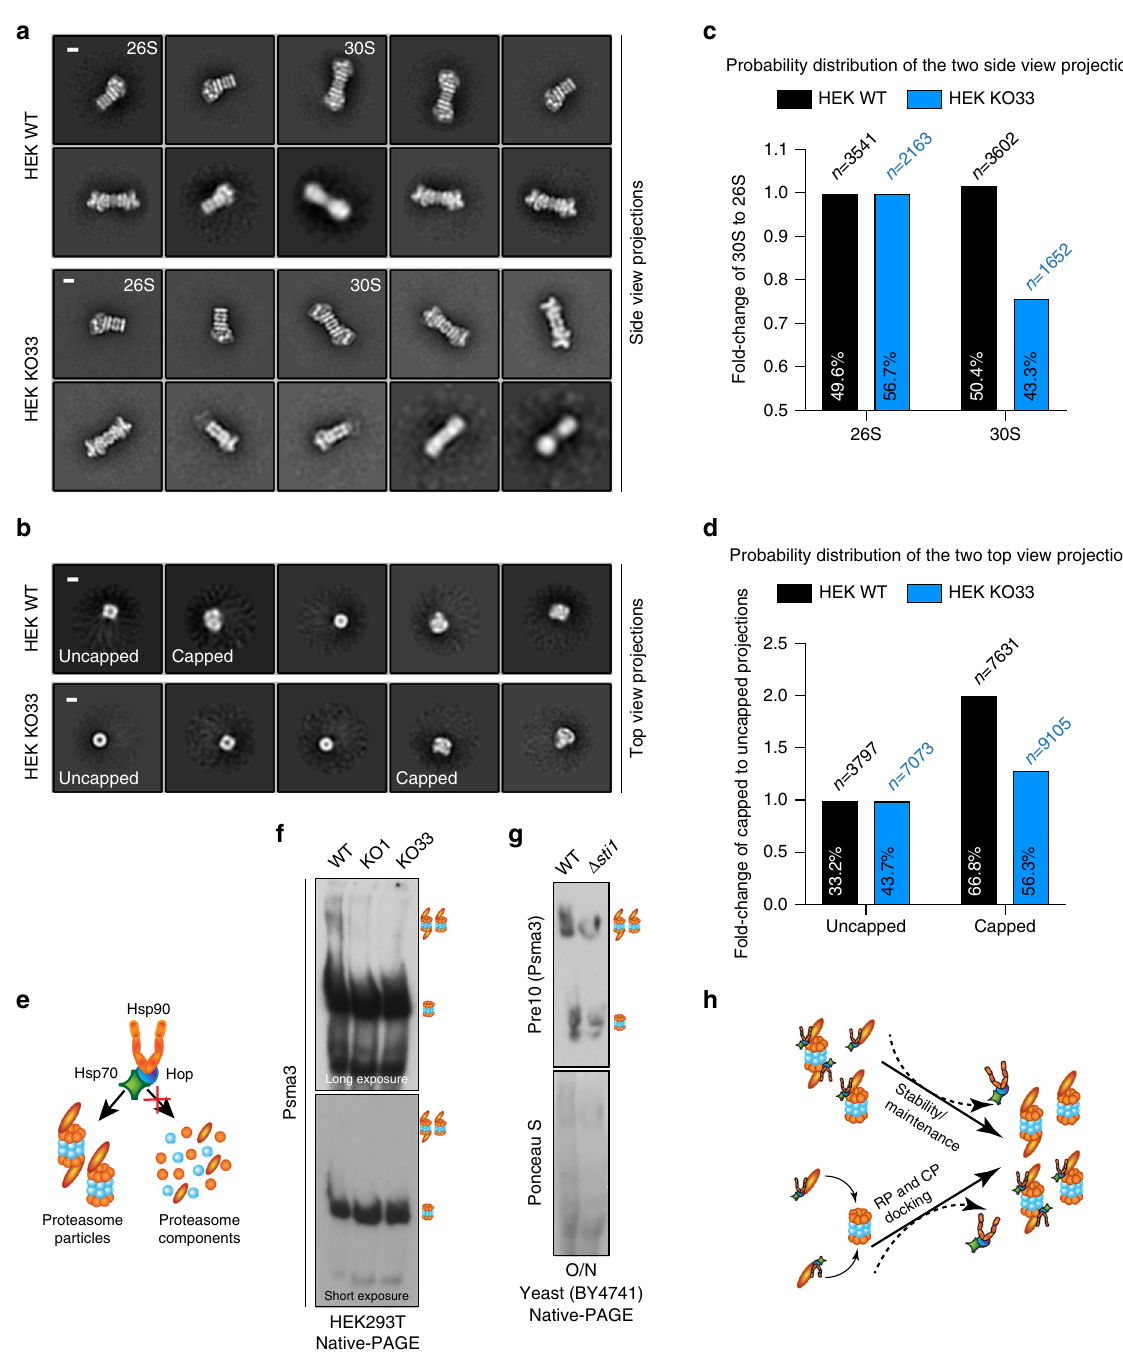
Fig. 5 Hsp70-Hop-Hsp90 ternary complex is required for proteasome assembly. a , b 2D class-averaged images of puri fi ed proteasome particles obtained by negative staining TEM. The top 10 and 5 classes are presented here for the side views (panel a ) and top views ( b ), respectively, of both the WT and KO samples. Representative side views of double-capped 30S and single-capped 26S particles, and representative top views of uncapped (CP face up, central hole visible) and capped (RP face up, central hole invisible) particles are indicated. Scale bar, 10 nm. c , d Quantitation of the fold changes of 30S over 26S (related to panel a ) and capped over uncapped (related to panel b ) proteasome particles between in WT and Hop KO samples. n, total numbers of structural projections of proteasome particles statistically analyzed with the software Relion. e Schematic representation of the involvement of the Hsp70-Hop-Hsp90 complex in proteasome particle assembly/maintenance rather than for individual proteasomal proteins. f , g Abundance of different proteasomal particles of human ( n = 5 independent samples over three independent experiments) and yeast cells ( n = 5 independent samples over 2 independent experiments) as indicated displayed by 4% native-PAGE and subsequent immunoblotting (with antibodies against the indicated proteasome component). Positions of 26S/30S proteasome particles and free 20S CP are indicated using the bands of puri fi ed proteasome particles as standards. Different exposures, for a given cell line, are from the same immunoblot. Nitrocellulose fi lters stained with Ponceau S indicate equal loading of proteins. h Models of how the Hsp70-Hop-Hsp90 ternary complex could enhance the abundance and stability of assembled 26S/30S proteasome